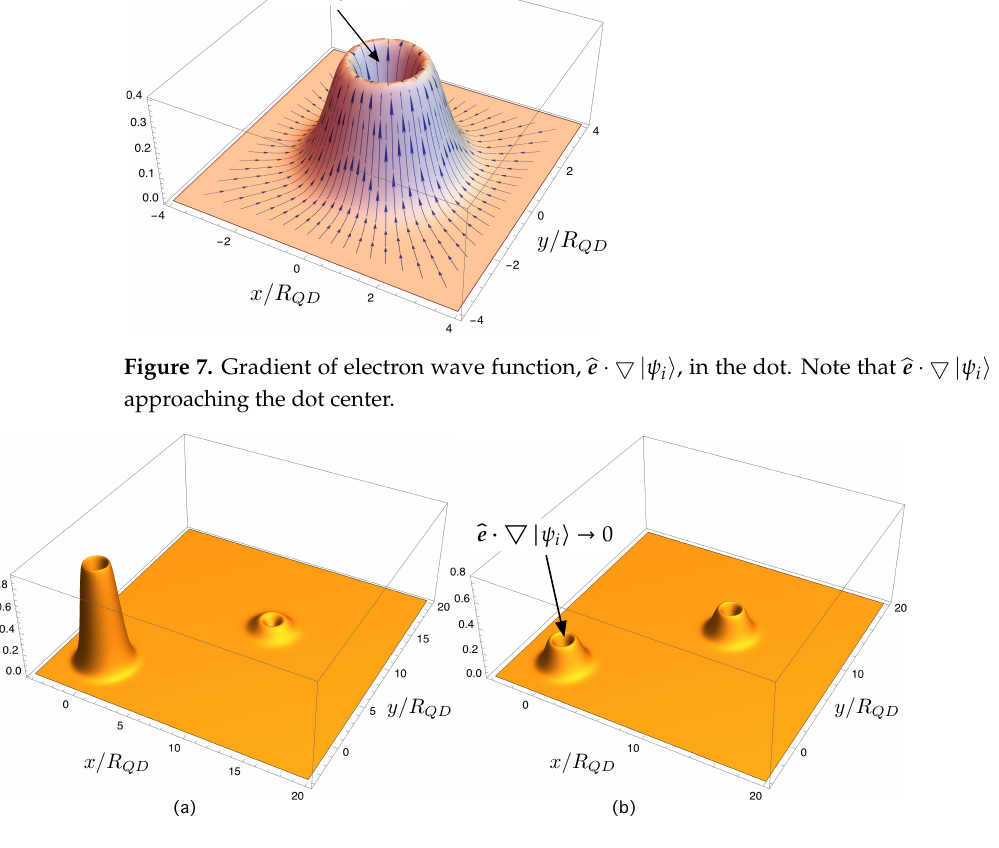
Figure 8. Gradient of electron wave function, (cid:98) e ψ i , in two cases. ( a ) Gradient of an initial state in which the probability · (cid:53) | (cid:105) components are very unbalanced. Its overlap with an extended final function on the continuum is expected to be very small. ( b ) Gradient of an initial state in which the probability components are unevenly distributed. Its overlap with an extended final function on the continuum is expected to be greater than in the case ( a